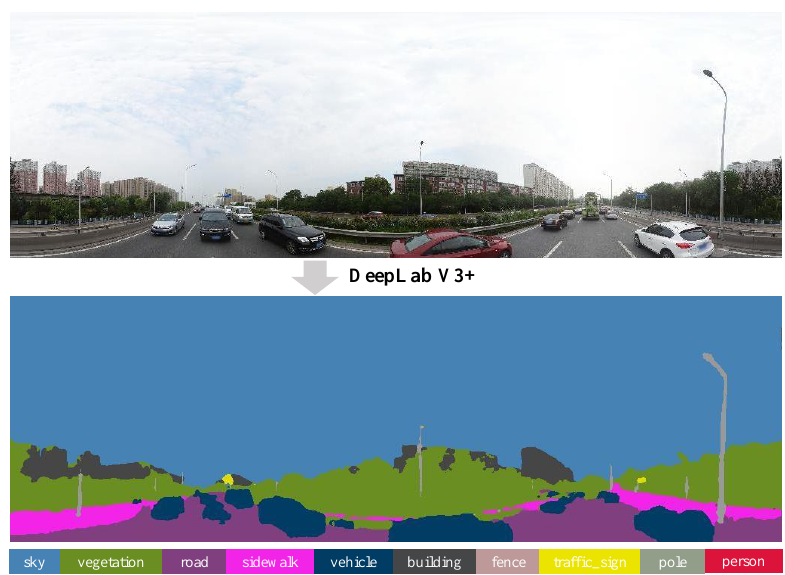
Figure 2. Semantic segmentation results for the BSV images with the DeepLab V3+ model. Based on the existing studies and related theories of house prices [29], this paper proposed six visual indices using the information extracted from the BSV images. The detailed computation method for each index is as